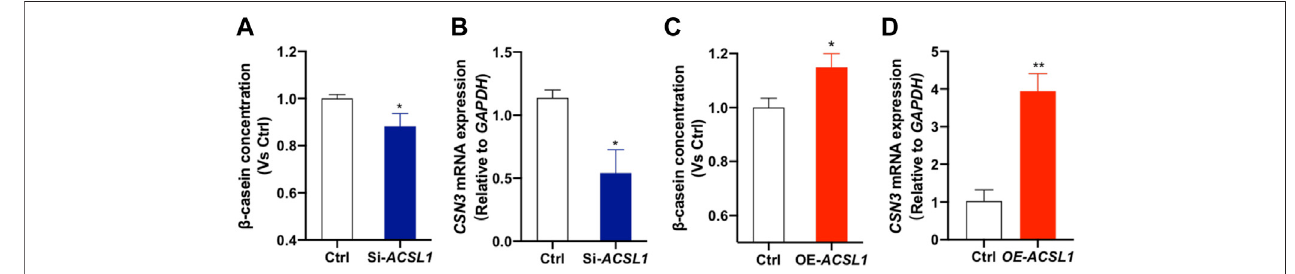
FIGURE 6 | ACSL1 regulated β -casein synthesis and κ -casein expression in MAC-T cells. (A,C) Content of β -casein in the MAC-T cell culture supernatant was determined by ELISA, and β -casein concentration was normalized by control (Ctrl); (B – D) mRNA expression of κ -casein ( CSN3 ) after ACSL1 knockdown or overexpression, and GAPDH was used as the inner control. * p < 0 .05; ** p <